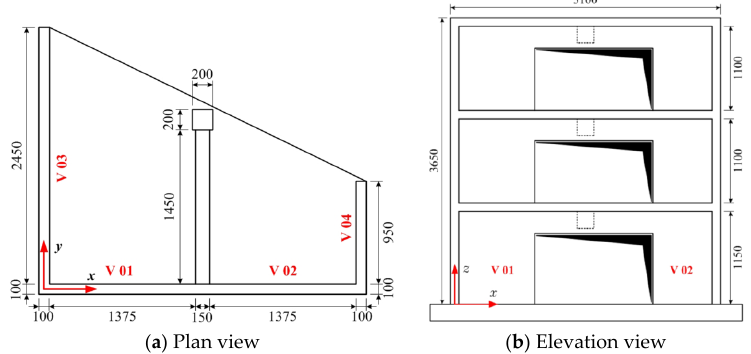
Figure 2. Plan and elevation views of the SMART 2013 reinforced concrete (RC) structure (unit: mm). Table 1. Dimensions of the structural components of the SMART (Seismic design and best-estimate Methods Assessment for Reinforced concrete buildings subjected to Torsion and nonlinear effects) 2013 reinforced concrete (RC) structure.